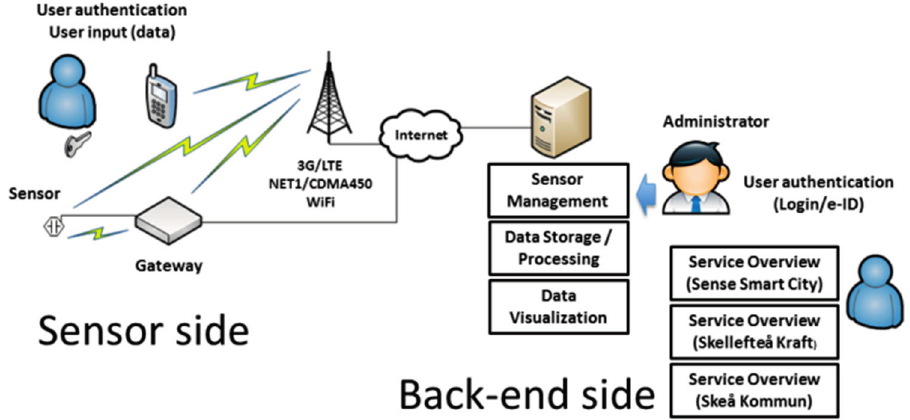
Figure 1. The Sense Smart City